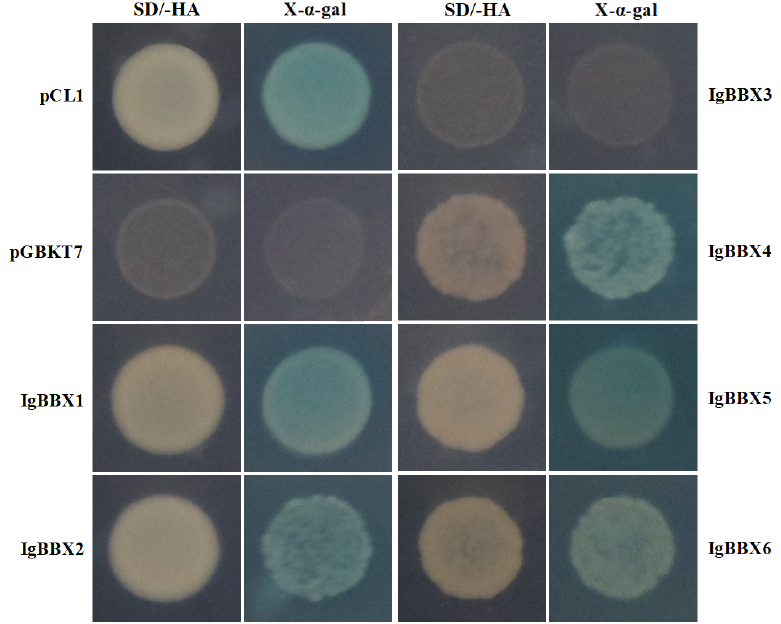
Figure 3. Transcriptional activity of the IgBBX TFs in yeast. SD/His-/Ade-: SD medium lacking his- tidine and adenine (on left side); X-a-gal: SD/His-/Ade- medium containing 20 mg/mL X-α-gal (on right side). pCL1 and an empty pGBKT7 are positive and negative controls, respectively.